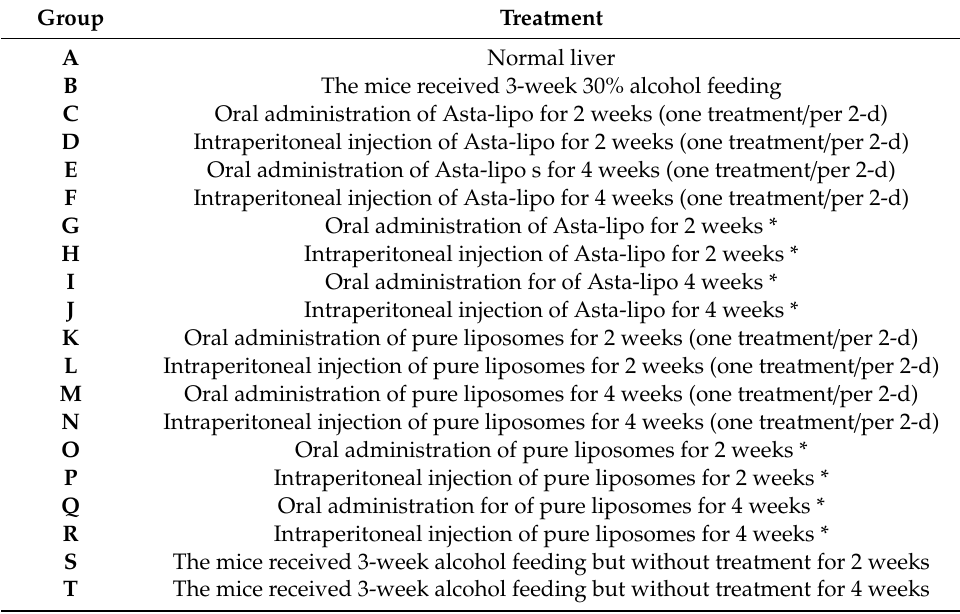
Table 2. Experimental groups and their treatment conditions on the mouse model of alcoholic liver